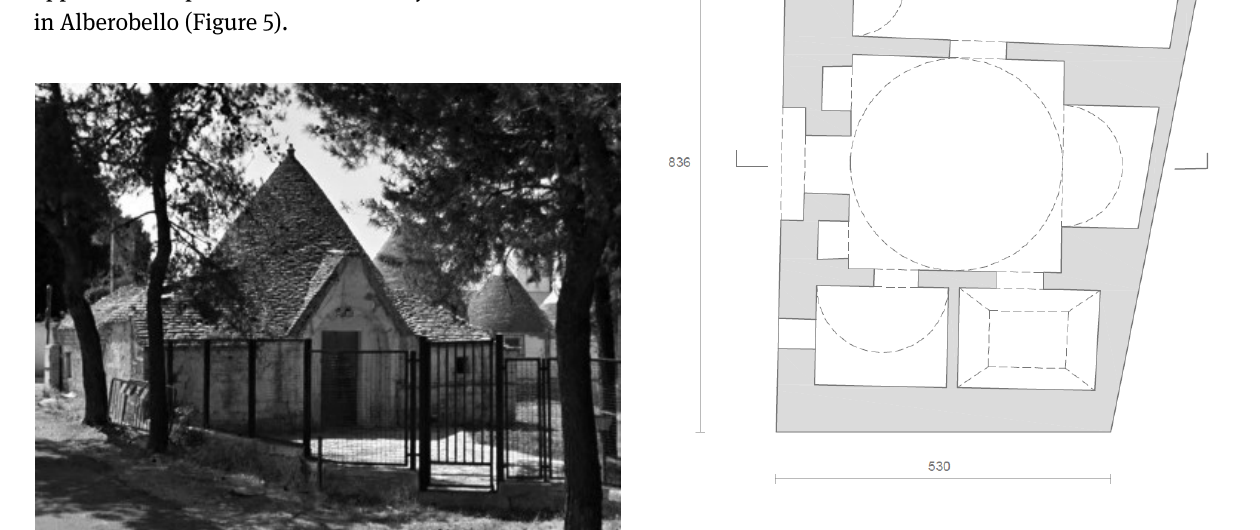
Figure 6: Cross-section and plan of the studied Trullo in